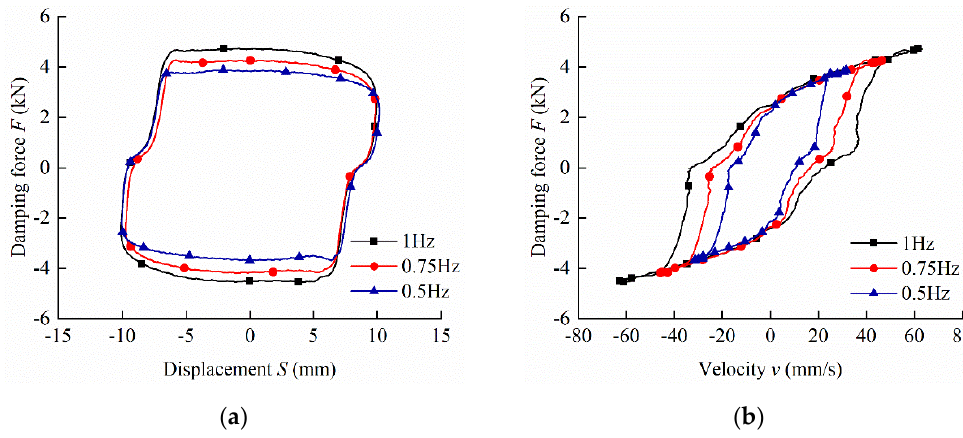
Figure 15. Damping force under different frequencies with the current of 1 A and the amplitude of 10 mm: ( a ) Damping force vs. displacement; ( b ) Damping force vs. velocity.